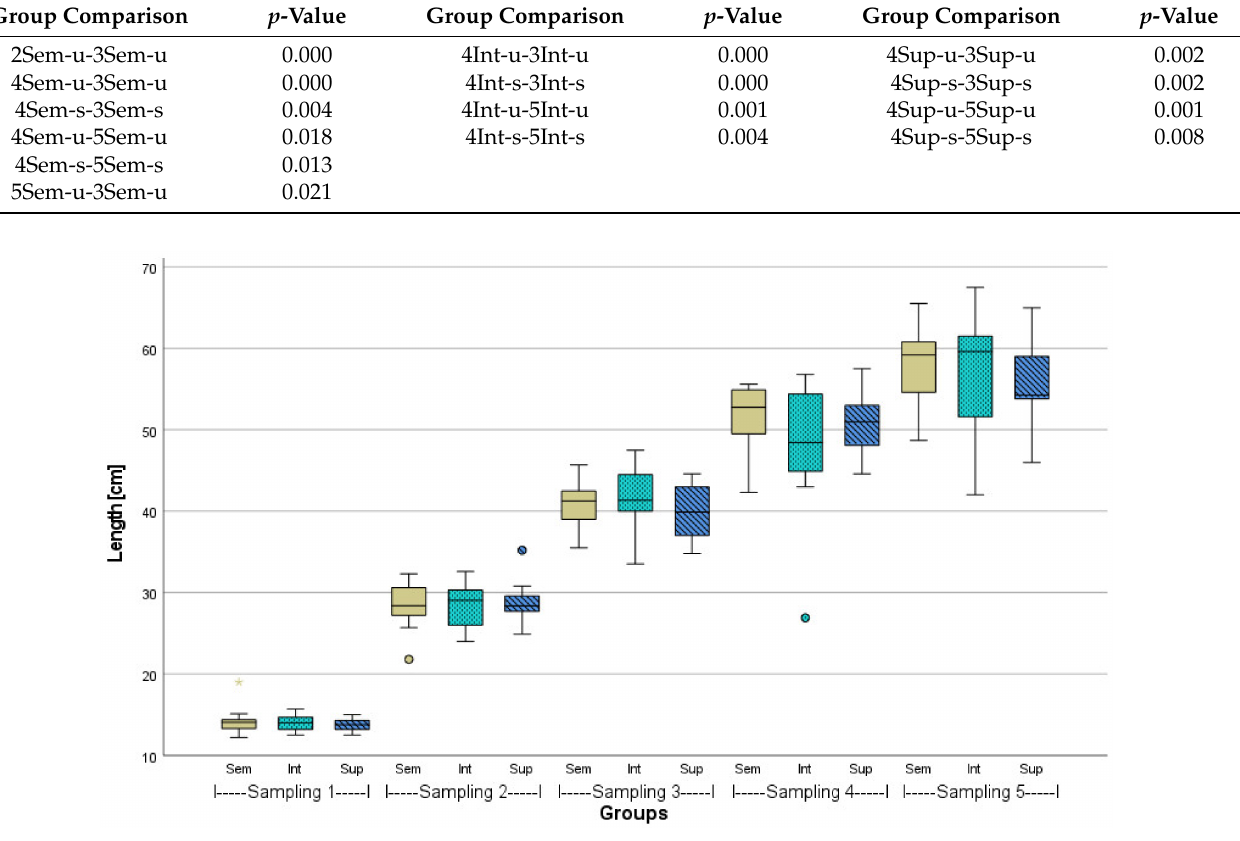
Figure A2. Total body length of African catfish from three different stocking densities (Sem = semi-intensive, Int = intensive, Sup = super-intensive) over 23 weeks, n = 18, p > 0.05 in respective samplings. Circlets = outliers, asterisk = extreme value.